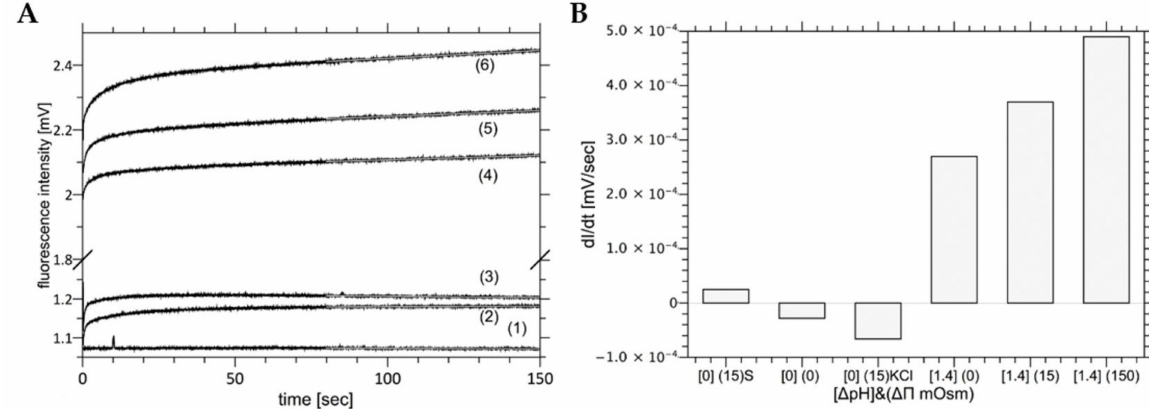
Figure 9. Panel ( A ) shows kinetics of fluorescence intensity changes caused by proton flow through liposome membrane exposed to different osmotic pressure differences at ∆ pH = 1.4. Curve 4 represents the curve for ∆ π = 0, Curve 5 for ∆ π = 15 mOsm, and Curve 6 for ∆ π = 150 mOsm. Curve 1 shows the fluorescence intensity when neither of gradients was present ( ∆ pH = 0 and ∆ π = 0). Curves 2 and 3 represent the case when at ∆ pH = 0 and ∆ π = 15 mOsm. Curves 2 and 3 were generated with KCl or sucrose as osmotically active ingredients, respectively. Panel ( B ) shows slopes of the linear part of kinetics presented in panel A as a function of the osmotic pressure difference and/or